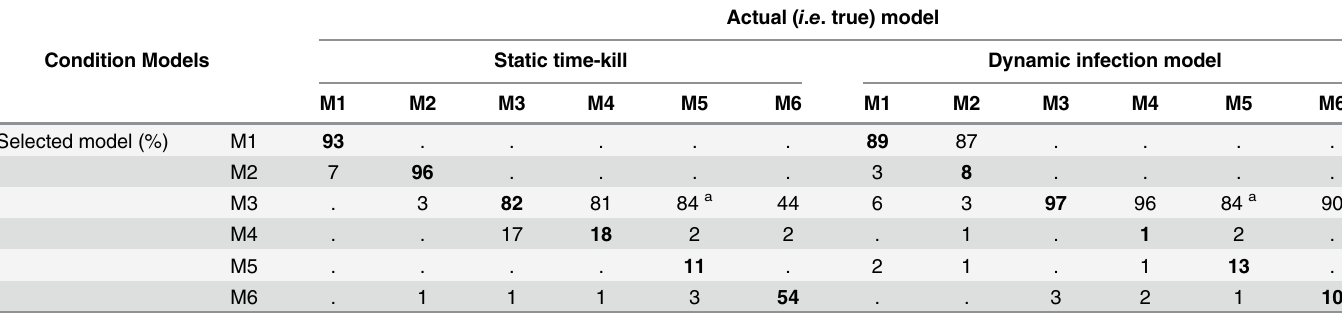
Table 3. Probability of selecting a model (M1 to M6) as the best model (lines) for six different true models (columns) used for simulation under dynamic or static conditions. The probability to correctly select the true model as the best model is represented by the diagonal (bold